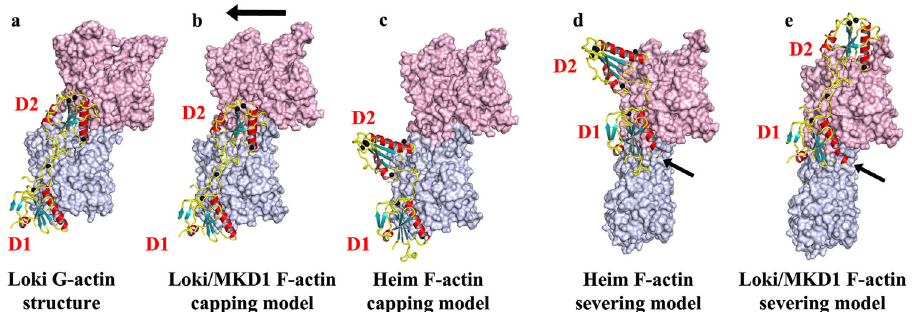
Fig. 7 Models of 2DGel action. a The structure of Loki2DGel bound to two molecules of G-actin. b Loki2DGel structure docked onto the lower actin (gray) an F-actin proto fi lament. The arrow indicates the translation of the second actin subunit in F-actin relative to the Loki2DGel/rActin structure. c Heimdall2DGel docked onto F-actin. d , e Models created by docking 2DGel onto the upper actin (pink) an F-actin proto fi lament. Arrows indicate steric clashes with the lower actin subunit. These proteins are incompatible with binding F-actin in these conformations. Steric clashes account for the sequestering and capping activities, via preventing a new actin monomer from joining another monomer or fi lament barbed end, respectively. Severing likely occurs when the 2DGel is located to the fi lament via D2 and/or the WH2 central motif allowing competition between D1 and the lower